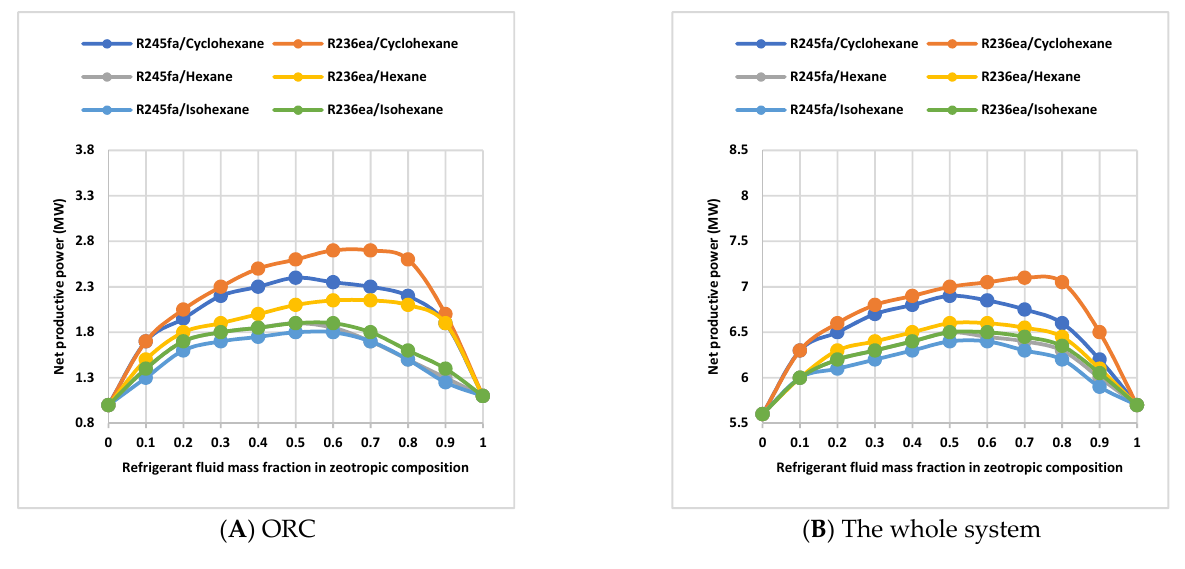
Figure 5. The net productive power of the whole system and the ORC to the mass fraction of refrigerants in the zeotropic composition.